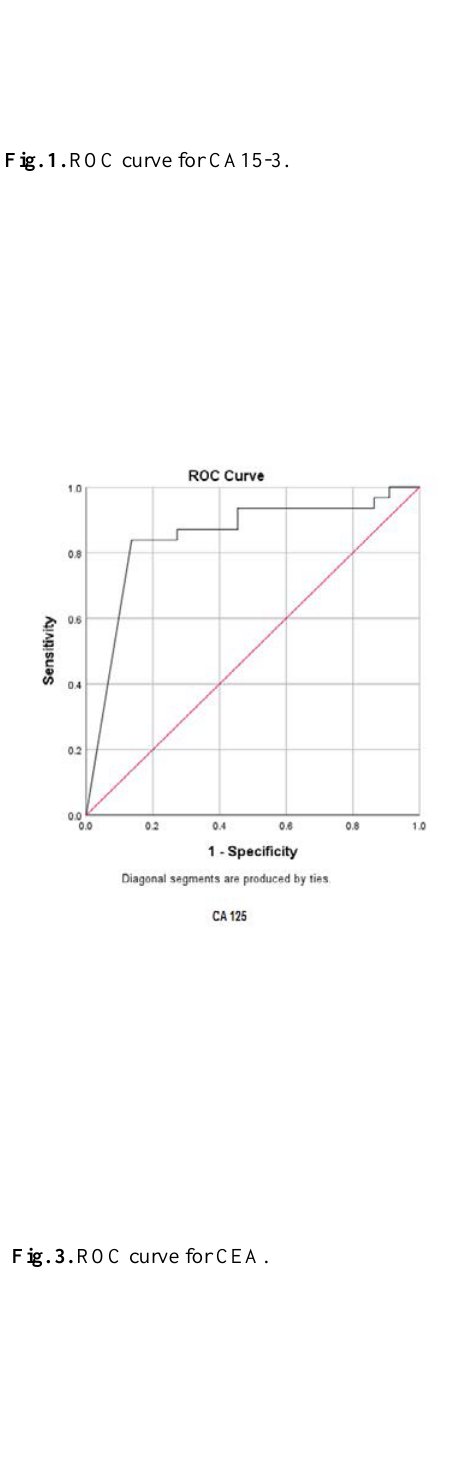
Fig. 1. ROC curve for